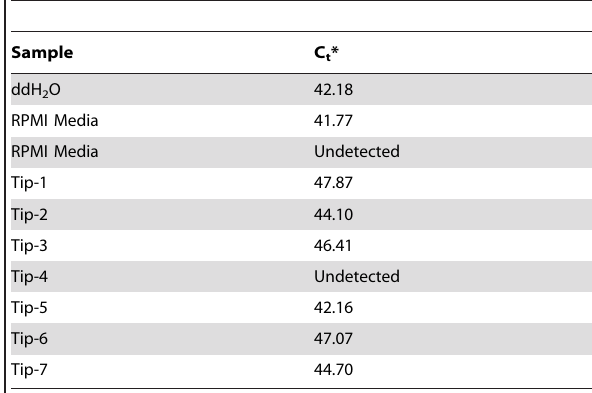
Table 2. Ct values for Control B samples.